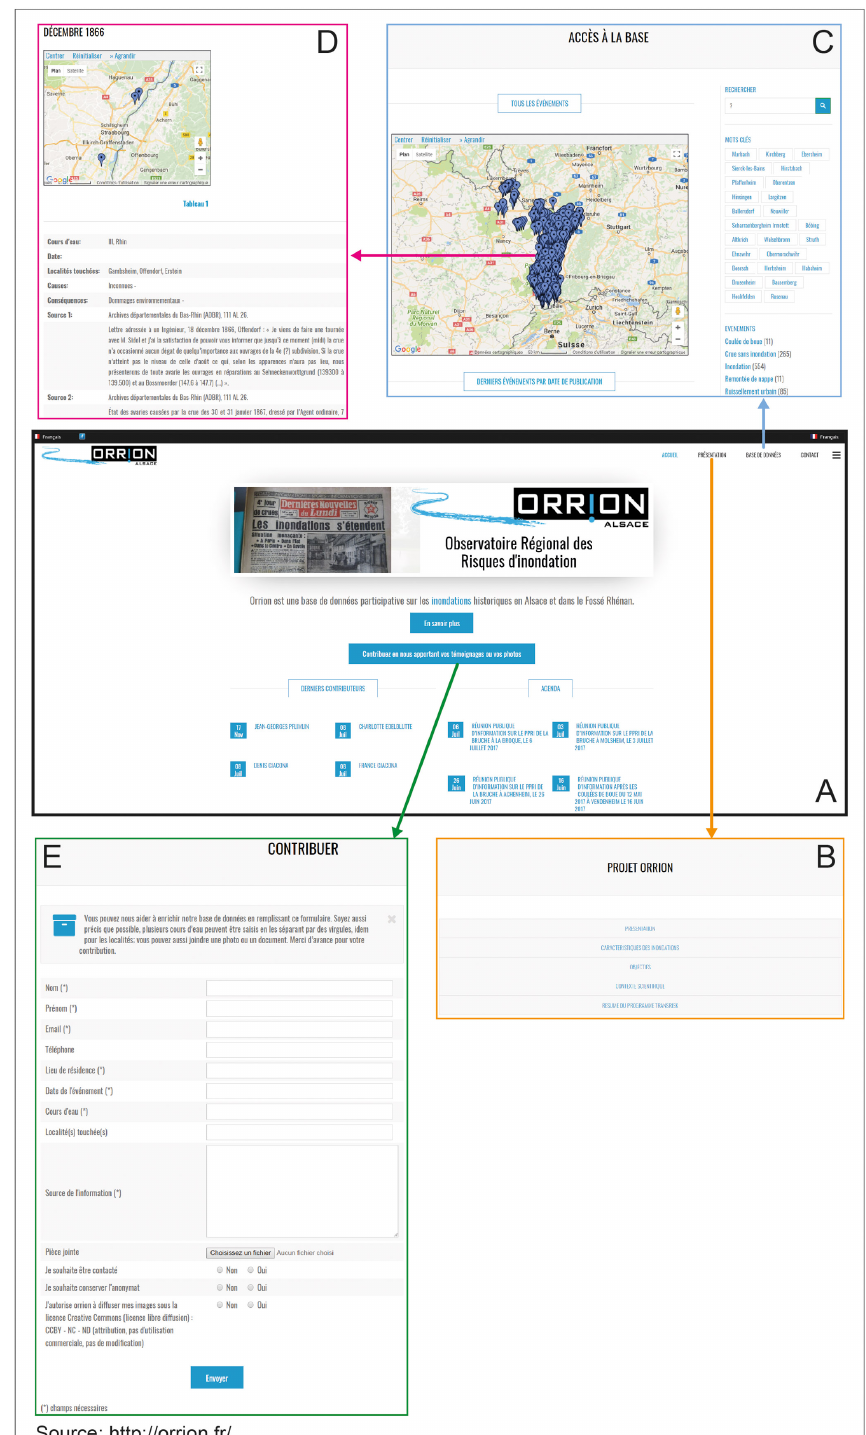
Figure 2. ORRION user interface (http://orrion.fr). (a) Home page. (b) Presentation of the project and of the main characteristics of floods in the Alsace region. (c) Database’s access page with a general map of all recorded events (© Google Maps). (d) Example of an article corresponding to a specific event (© Google Maps). (e) Contact form to post a participative contribution.